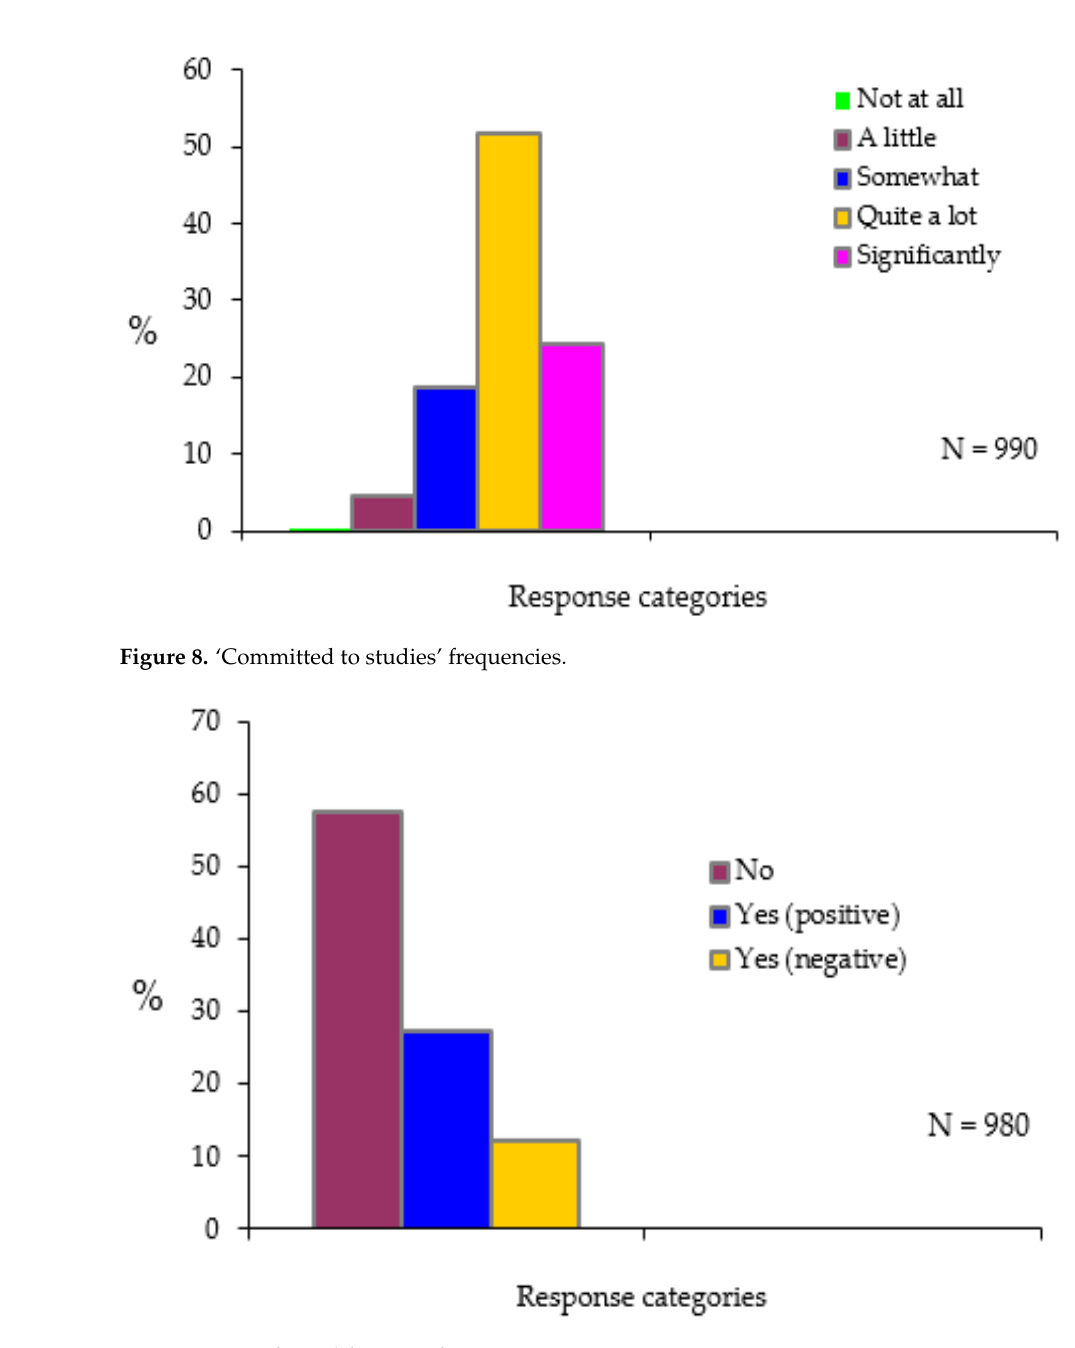
Figure 9. ‘Significant life event’ frequencies.